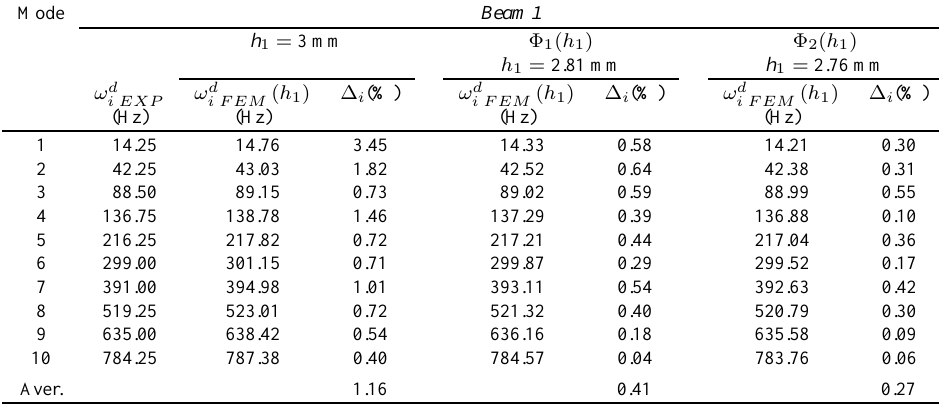
Table 2 Flexural frequencies and residuals for the Beam 1 calculated using identified damage extent